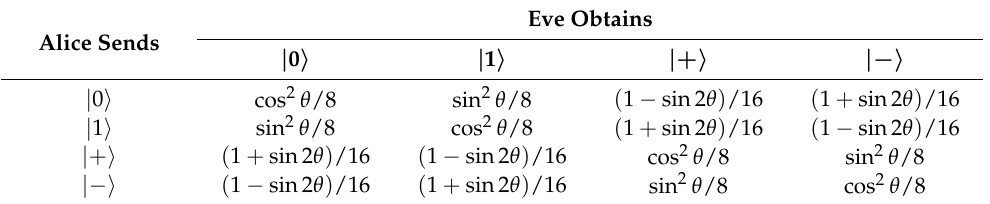
Table 1. A summary of joint probabilities when Alice prepares a particular state and Eve obtains measurement outcomes corresponding to each of the four states on qubits that Alice sent. Alice